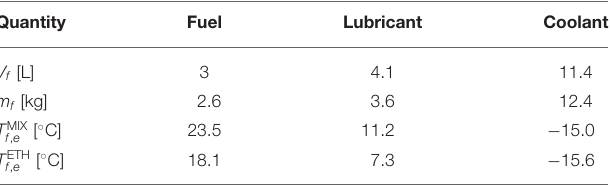
TABLE 1 | Different application cases of a TES system based on 13X zeolite and liquid sorbate (MIX: 30:70%wt. ethanol-water mixture; ETH: ethanol), which is envisioned to increase the temperature of the engine fluids of a genset (F9.5-1 by FG Wilson) during the